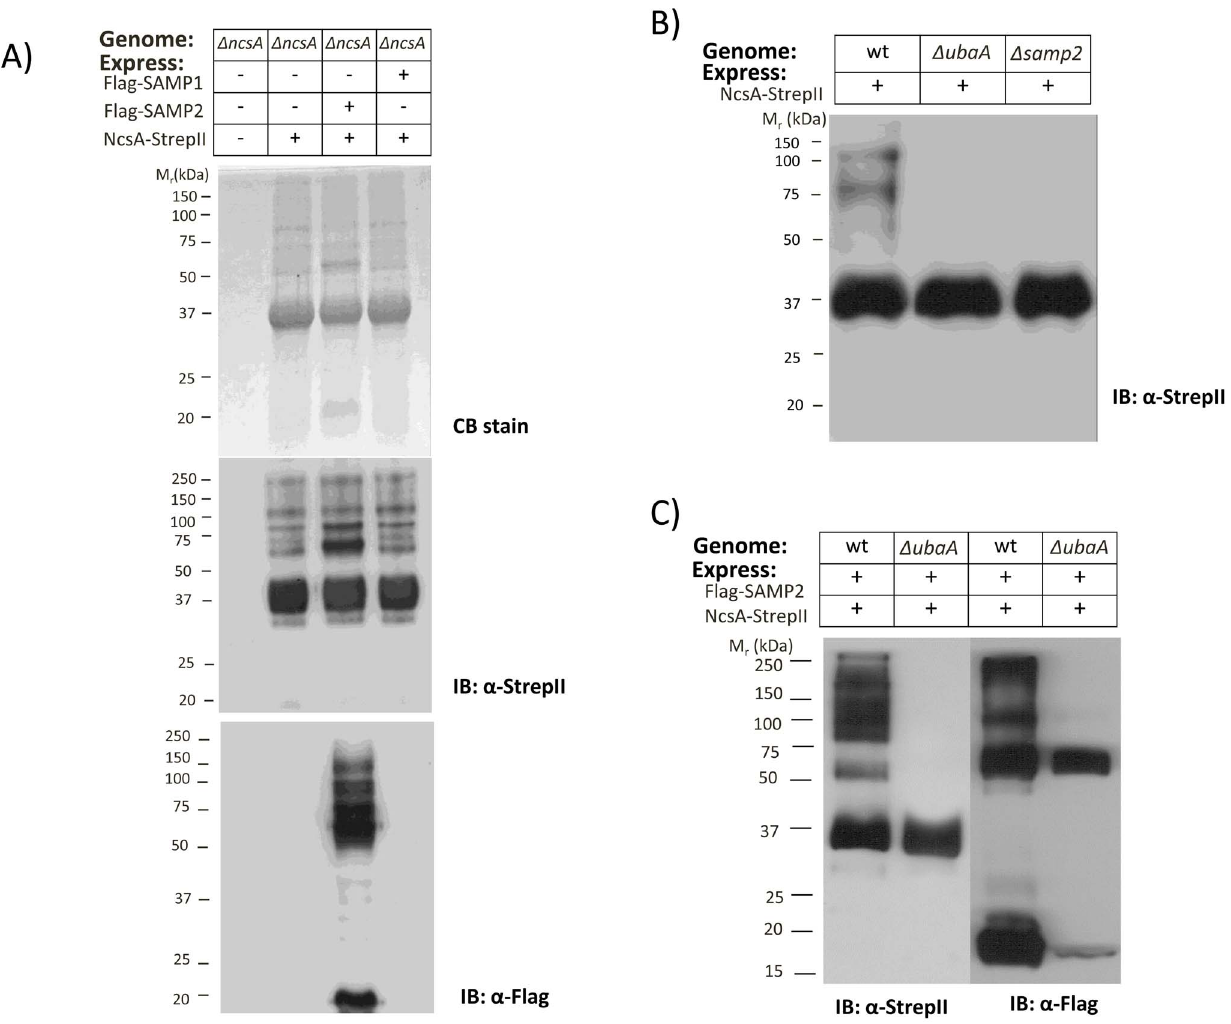
Figure 4. NcsA is covalently associated with SAMP2 through a UbaA-dependent mechanism. A) NcsA StrepII-affinity purified fractions purified from D ncsA strains expressing NscA-StrepII with and without Flag-SAMP1/2 proteins were separated by reducing SDS-PAGE and analyzed by Coomassie blue stain (upper panel) and a -StrepII and a -Flag IB (middle and bottom panels, respectively) as indicated. B) a -StrepII immunoblot of NcsA-StrepII purified from H26 (wt, parent), D ubaA , and D samp2 . C) a -Flag immunoblot of NcsA-StrepII purified from H26 (wt, parent) and D ubaA strains co-expressing Flag-SAMP2. Molecular weight markers are indicated to the left of each blot. Pull down assays were from 1 L cultures. See Methods section for